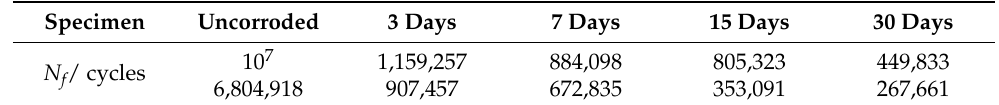
Table 2. Fatigue life of 5083/6005A welded joints.